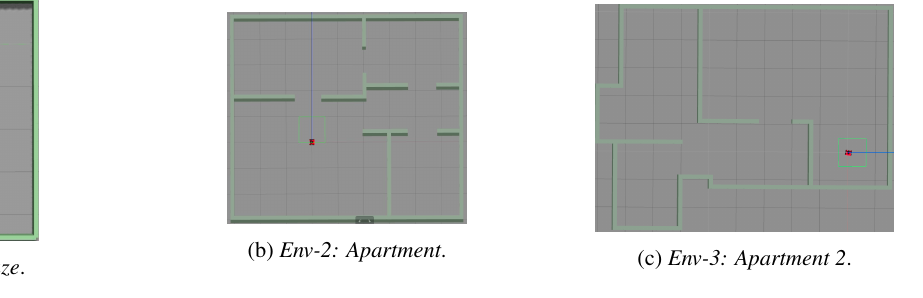
Figure 1: The environments are of size 22, 68 and 65.5 m 2 ,